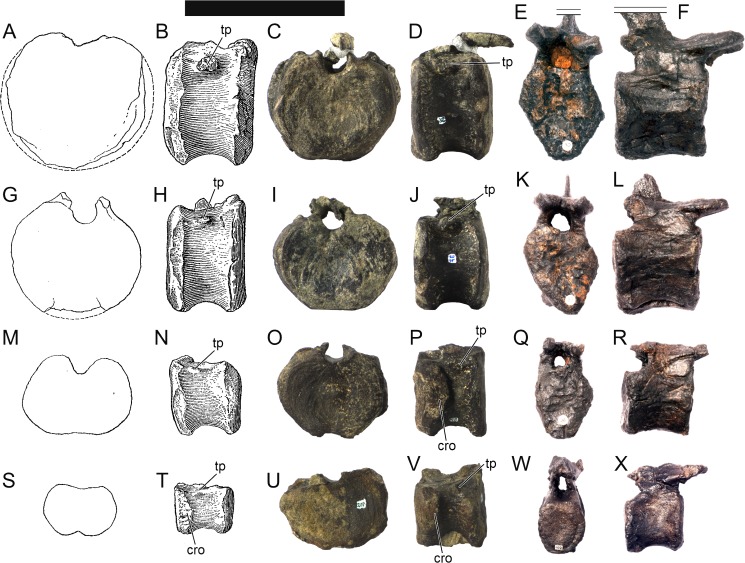
Compared posteriormost caudal vertebrae of Miragaia longicollum MG 4863.A, B, G, H, M, N, S, T, posteriormost caudal vertebrae of A. longispinus UW 20503 (modified from [33]), C, D, I, J, O, P, U, V, MG 4863 (mirrored for improved exhibition of the features discussed), E, F, K, L, Q, R, W, X,
S. stenops NHMUK PV R36730 (from [19]), C, D, Cd30, E, F, Cd29, I–L, Cd32, Q, R, Cd35, O, P, Cd36, U–X, Cd37 in A, C, E, G, I, K, M, O, P, R, S, U, W, anterior view and B, D, F, H, J, L, N, P, R, T, V, X, right lateral view. The neural spines of E and F were cut for better visualization. Cro, lateral centrum rim ossification, tp, transverse process. Scale bars equal to 10 cm.